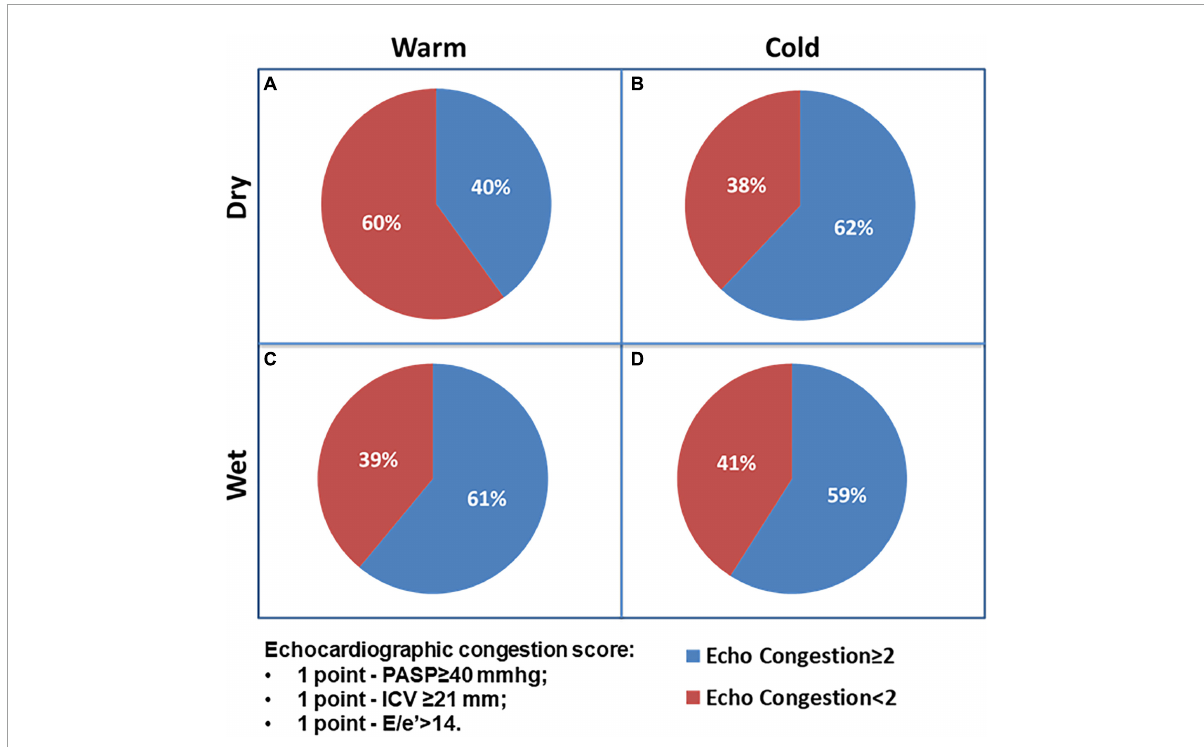
FIGURE3 The Chi-square test for prevalence of echocardiographic congestion score ≥ 2 among AHF patients’